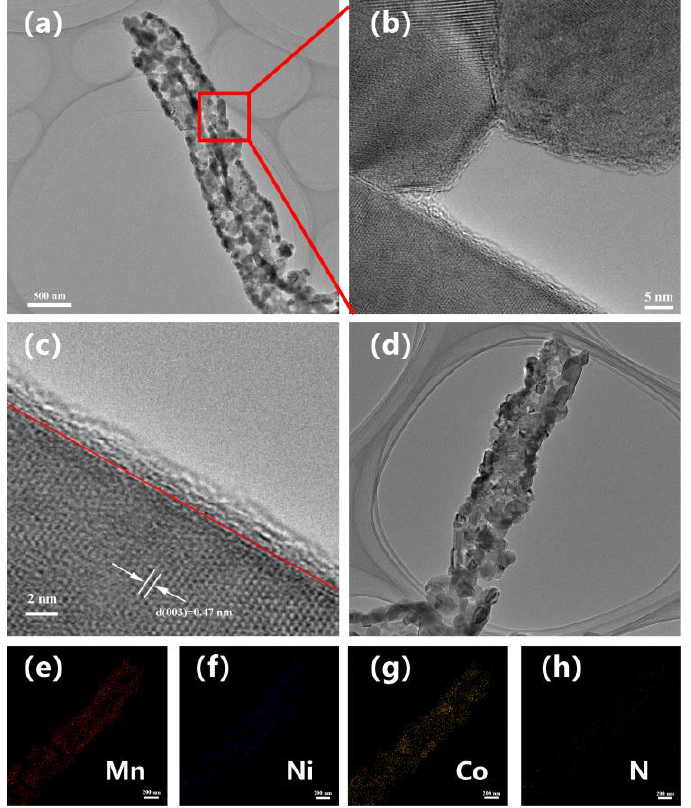
Figure 4. ( a – d ) HRTEM images of P-LMNCO sample. ( e – h ) EDX mapping of P-LMNCO sample.